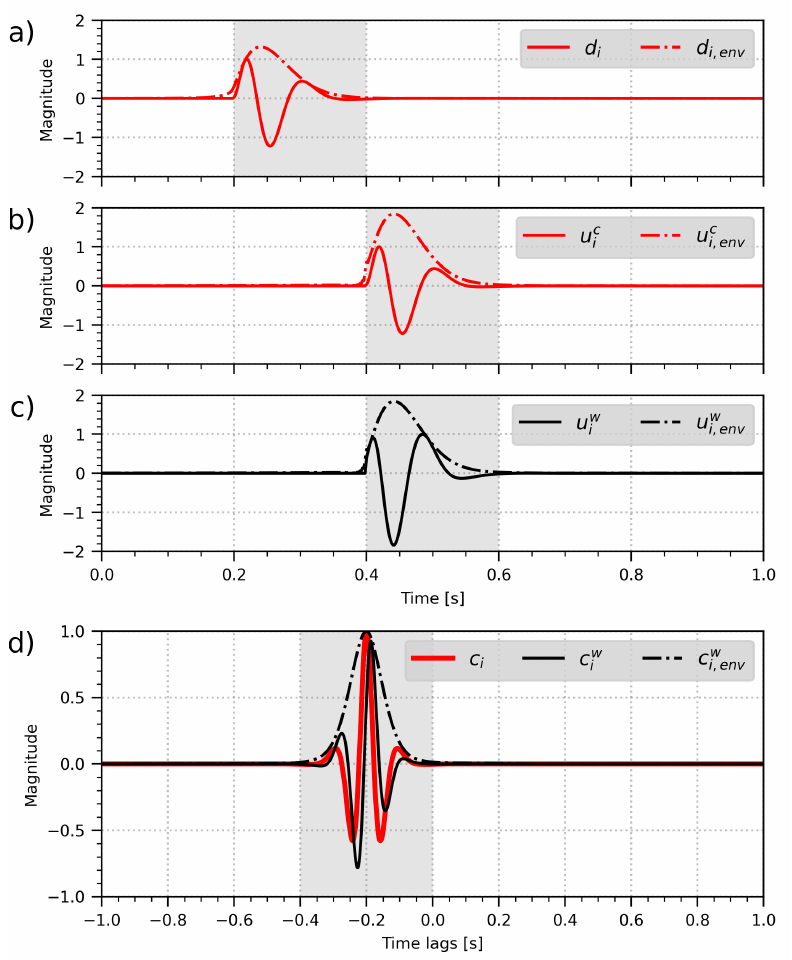
Figure 2. ( a ) Observed trace d i (solid-red line) and its envelope d i , env (dash-dotted-red line); ( b ) syn- thetic trace u c (solid-red line) with correct wavelet and its envelope u c i ( c ) synthetic trace u w with wrong wavelet (solid-black line) and its envelope u w i line); ( d ) c i is the cross-correlation between observed trace d i and the synthetic trace u c line). c w is the cross-correlation between d i and u w i between d i , env and u w (dash-dotted-black i , env